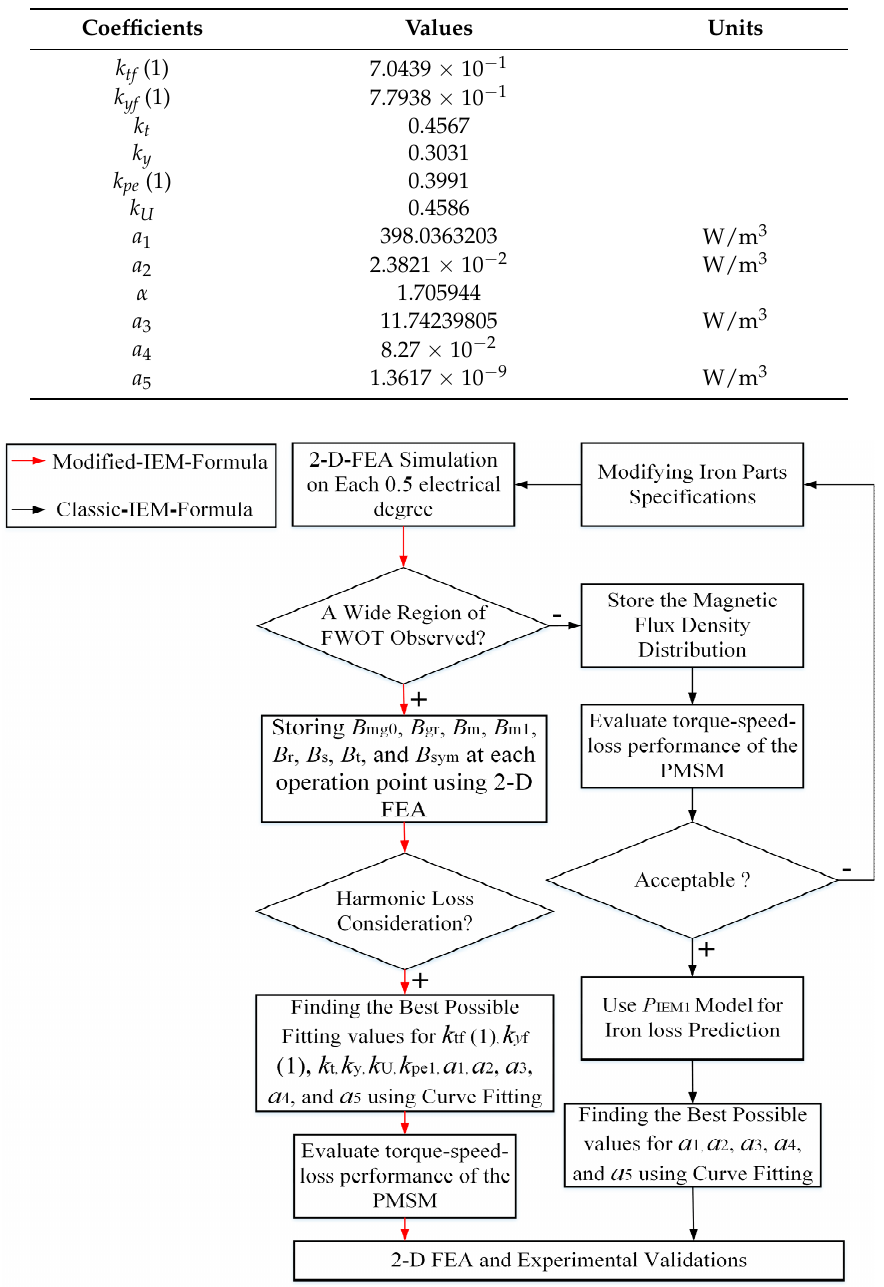
Figure 4. Comparison of no-load air-gap magnetic field density waveforms using Equations (21) and Coefficients calculation using the modified institute of electrical machine formula (27), for ( a ) fundamental no-load magnetic induction ( B m 1 ), and ( b ) no-load airgap magnetic induction (IEM-Formula) by curve fitting. ( B m ).